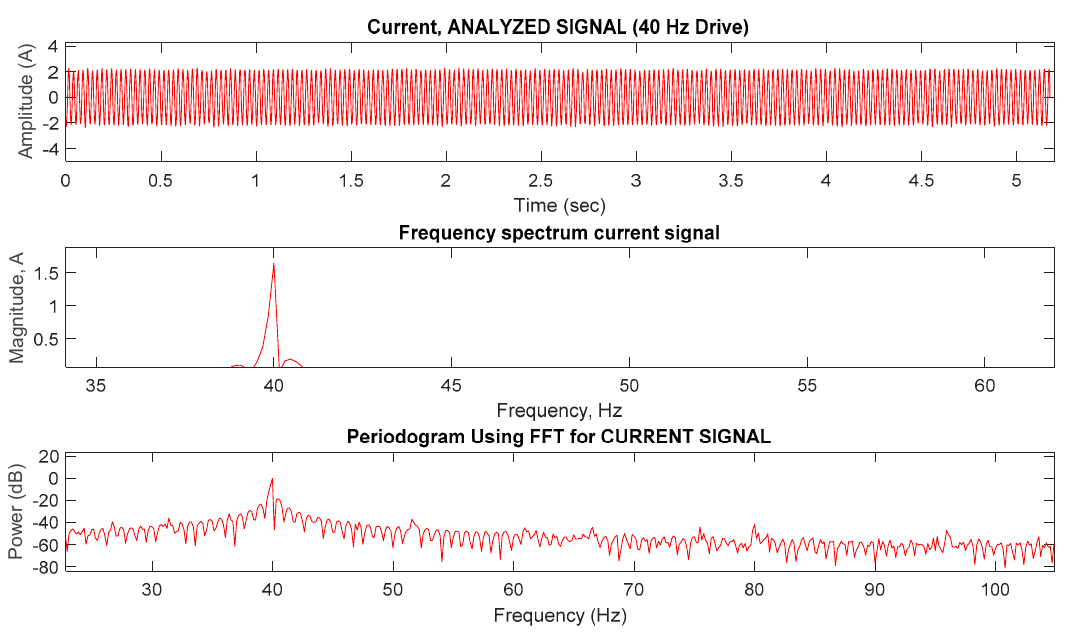
Figure 9. FFT analysis of current signal measurement of motor line current of phase A, frequency spectrum, and periodogram at 50 Hz speed operation.